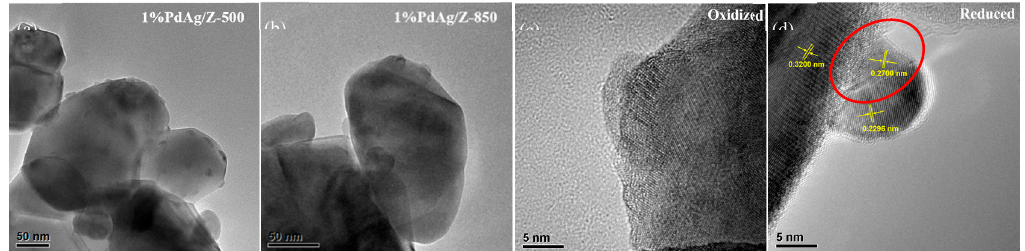
Figure 2. HRTEM images of supported alloy catalysts: ( a ) PdAg/Z-500; ( b ) PdAg/Z-850; ( c ) PdAg/Z-500 were re-oxidized under air at 500 °C; ( d ) H 2 re-reduced at 500 °C.